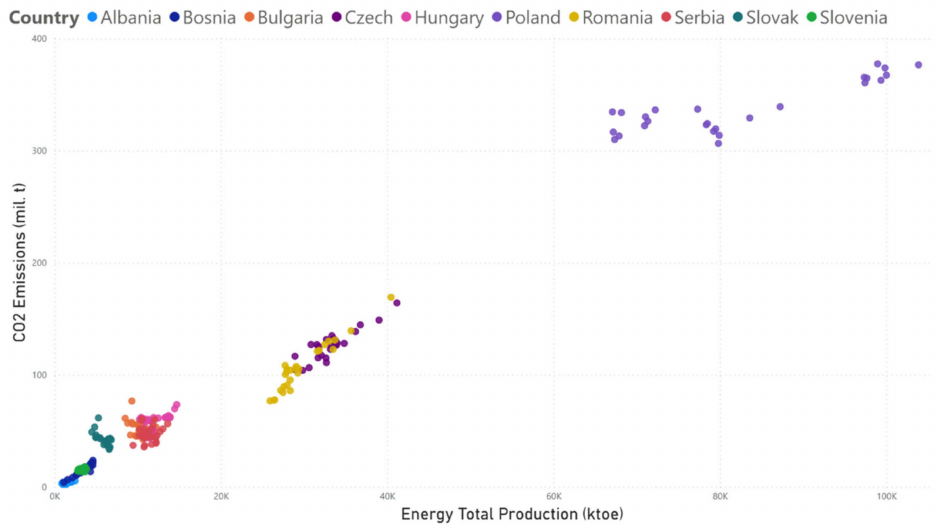
Figure 1. Energy Total Production and CO 2 emissions—Country Clusters (1990–2015). Also, as depicted in Figure 2, for most countries, the urban growth rate is not neces- sarily related with the CO 2 emissions value.